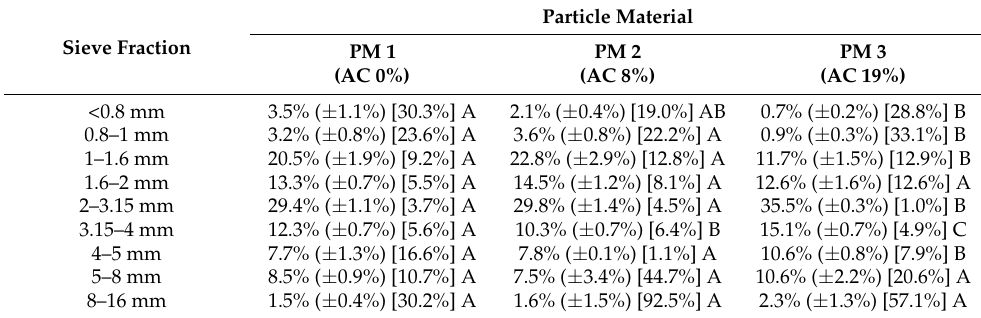
Table 2. Relative mass, fluctuation range (round brackets: standard deviation; square brackets: coefficient of variation), and results of statistical analysis (homogeneous groups, indicated as capital letters) of sieve-analyzing the particle materials of different adhesive